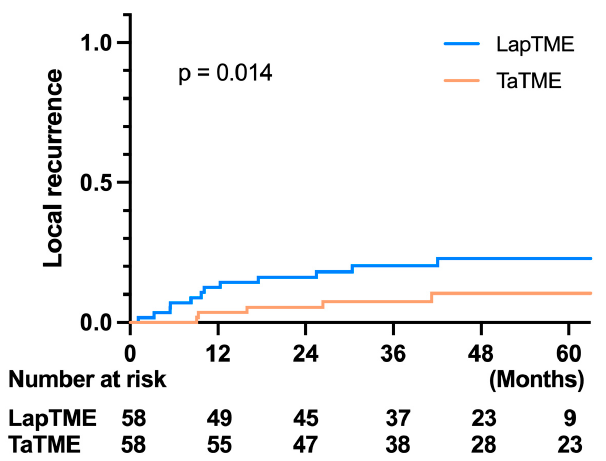
Figure 4. Kaplan–Meier survival curves of LR between the TaTME and LapTME groups.